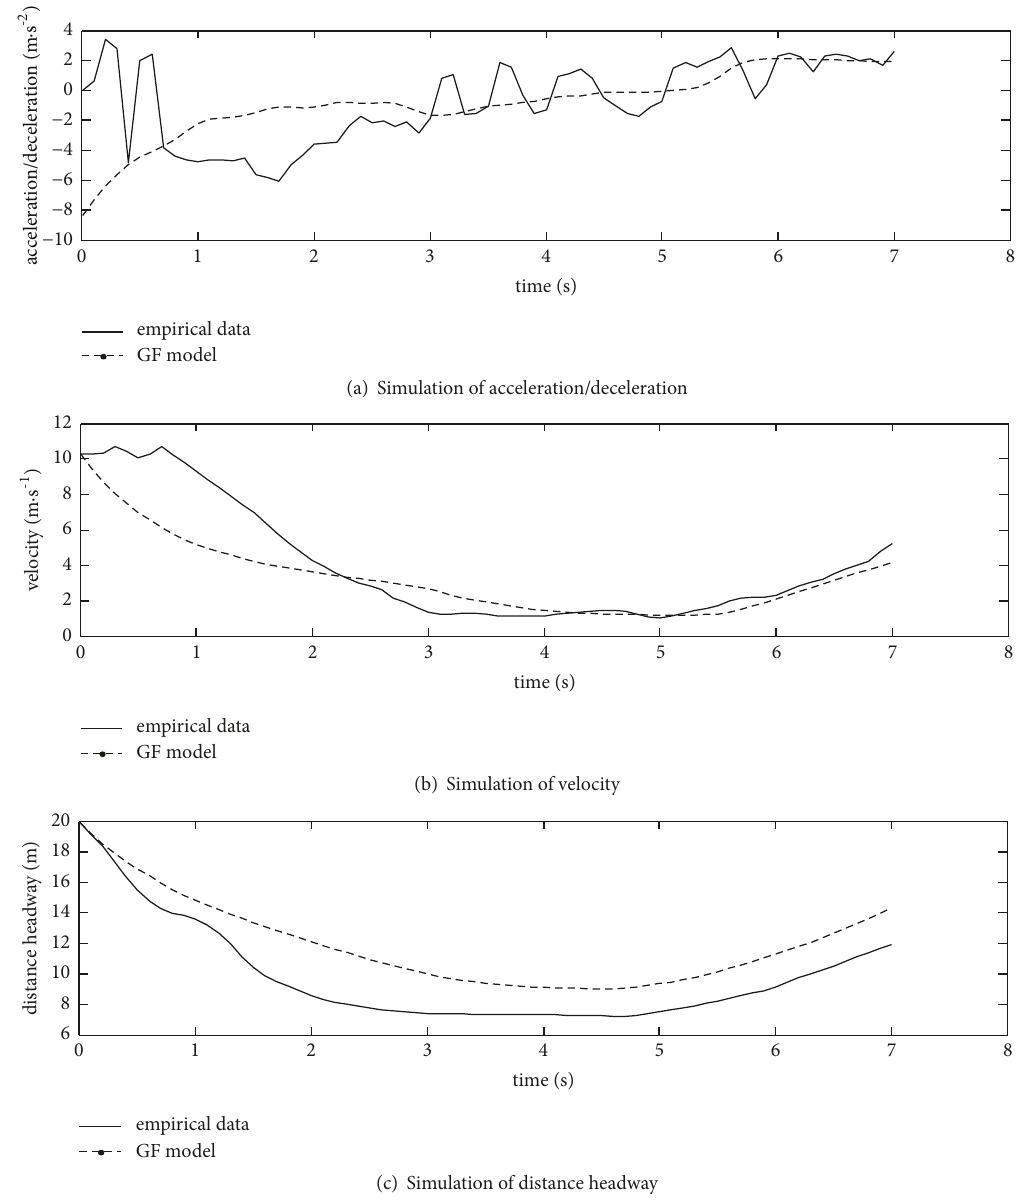
Figure 5: GF model simulations of car-following Process